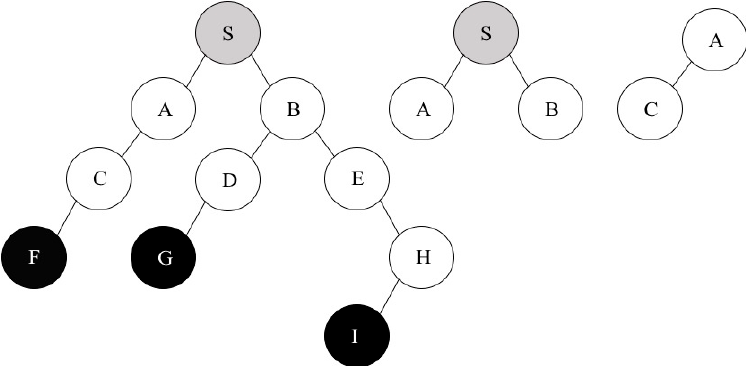
Figure 2. Multicast tree and children of S and A.